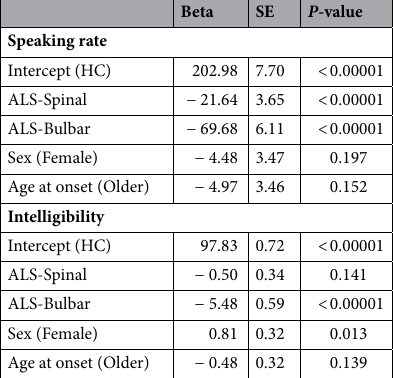
Table 2. Multiple regression analyses to estimates the effects of group, sex, and age on functional speech measures.